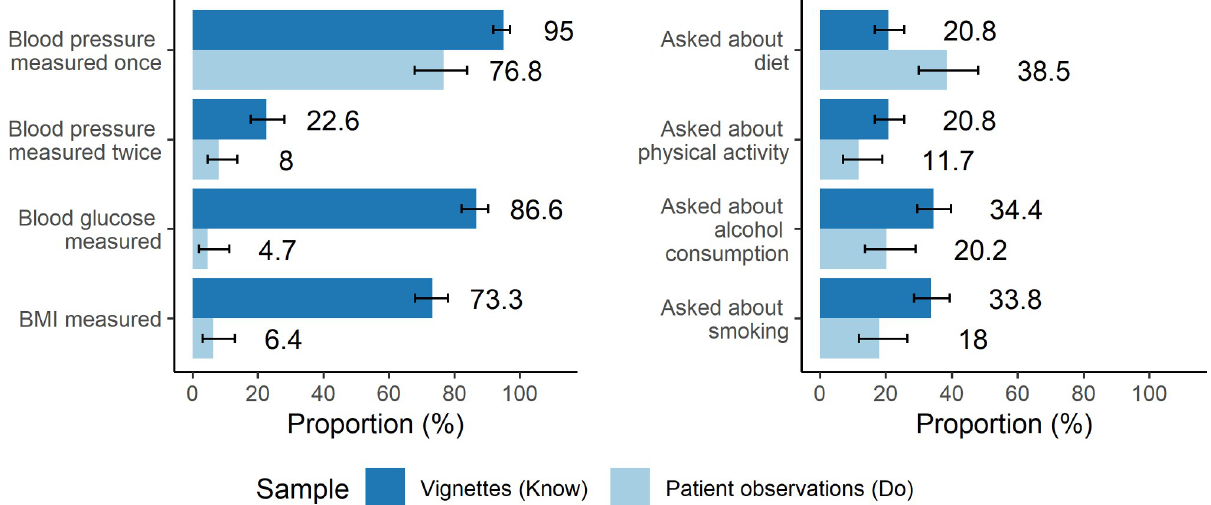
Fig 1. Know-do gaps for non-communicable disease screening measurement actions and behavioral risk assessments. Error bars represent 95% confidence intervals.